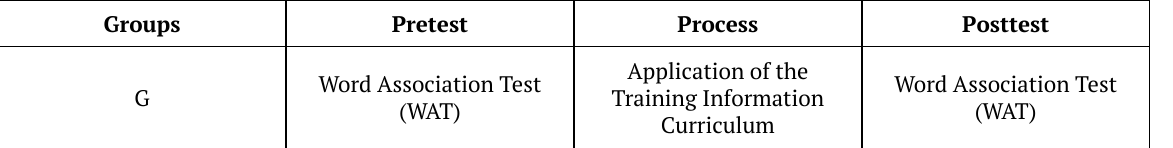
Figure 1. Single Group Pretest - Posttest Pattern